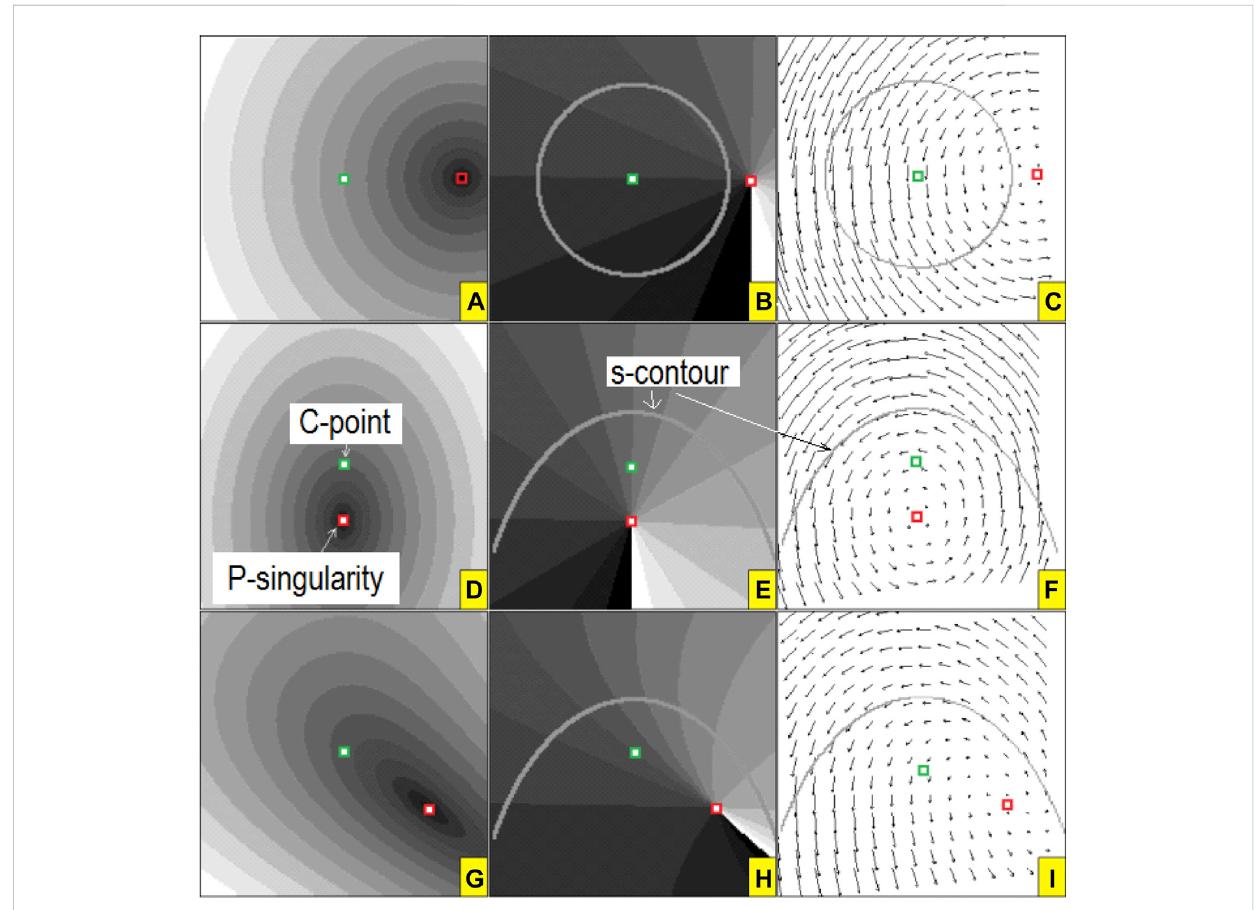
FIGURE 14 Shift of the P -singularity (vortex of the transverse Poynting vector Eq. 5.6) in the full Poincare beam [84, 105] due to asymmetry of amplitude a + ( x , y ) and phase ε + ( x , y ) of the smooth polarization component Eq. 5.11. Only the asymmetry in horizontal direction is considered ( z a + / z y = z ε + / z y = 0). Panels (A, D, G) : distribution of the modulus| U ⊥ |; (B, E, H) : distributionof the U ⊥ azimuth (color-encoding conventions are the same as in Figure 13); (C, F, I) : full vectorplotswithlocalstrengthsandorientationsdepictedbyarrows.1 st row ( A – C) illustratethein fl uenceofamplitude asymmetry( a + variable, ε + = const);2 nd row (D – F) — effectofthephaseasymmetry( ε + isvariable, a + =const);3 rd row (G – I) — combinedeffectofthephaseandamplitudeasymmetries. Symbols , denote the C -point and P -singularity, respectively. The gray line in fi gures (B , C , E , F , H , I) indicates the s